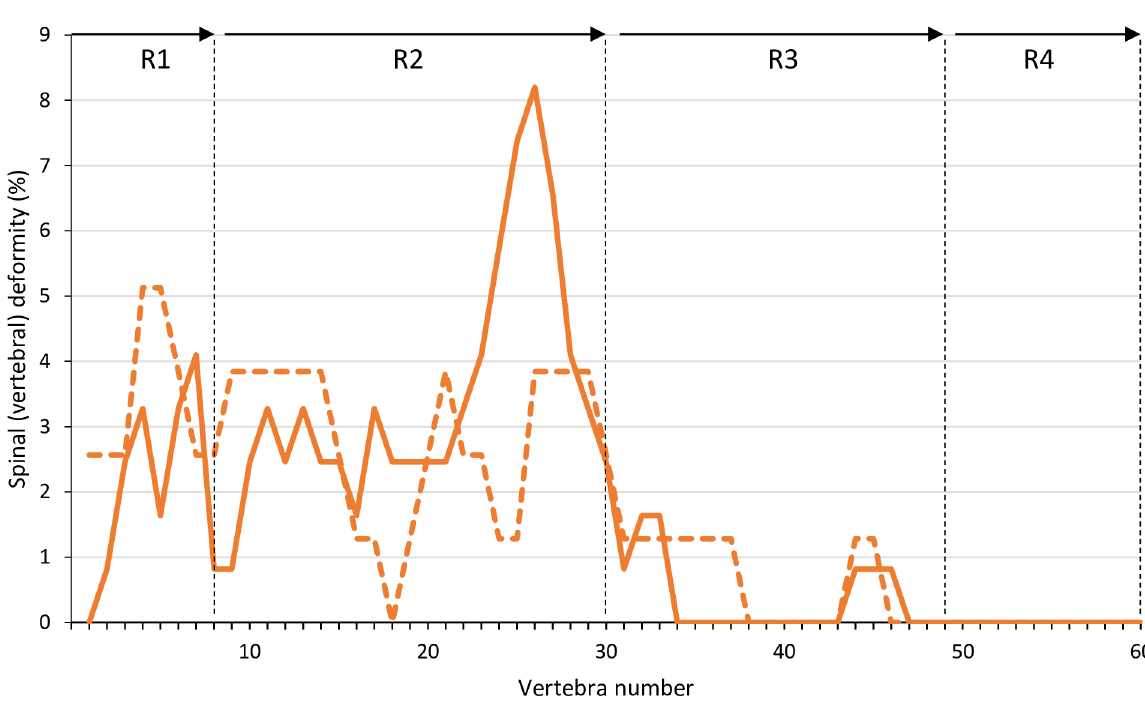
Fig 8. Occurrence of deformed vertebrae in triploid salmon smolt. Percentage of deformed vertebrae in different regions (R1-R4) of the spinal column of triploid Atlantic salmon, Salmo salar , smolt (2745 ddPSF) fed fish meal (STD) (solid line) and hydrolyzed fish protein (HFM) (dashed line) diets. Vertebral regions according to Kacem et al. [19]; R1 = cranial trunk, R2 = caudal trunk, R3 = tail region and R4 = tail fin.